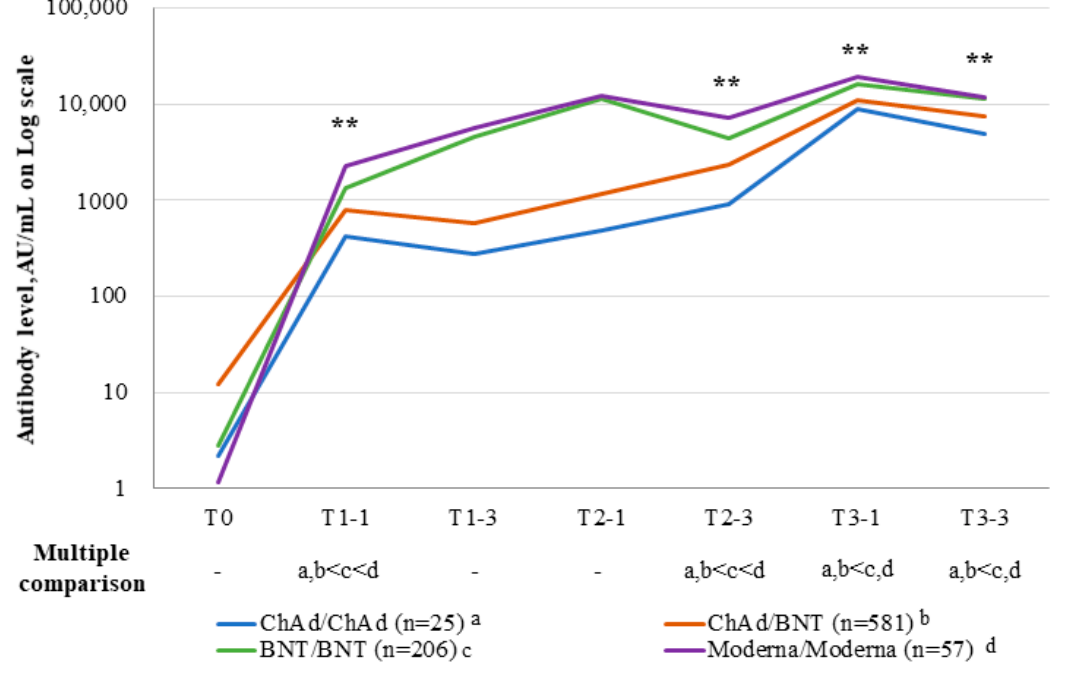
Figure 3. Change in anti-SARS-CoV-2 S-RBD IgG levels between 1 (T3-1) and 3 (T3-3) months after the third vaccine in each group. Abbreviations: T3-1 (1 month after the third dose); T3-3 (3 months after the third dose). P -values ( p < 0.001) were obtained using paired t -tests in each group.